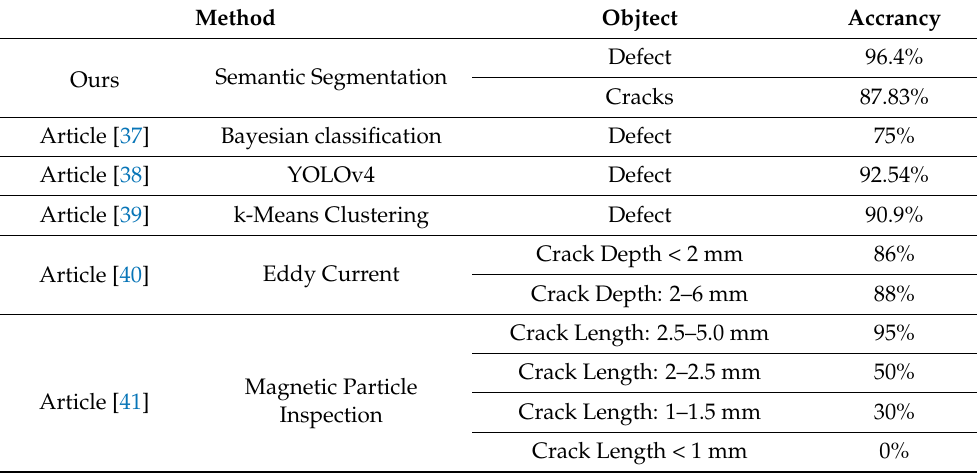
Table 3. Comparison of results with other